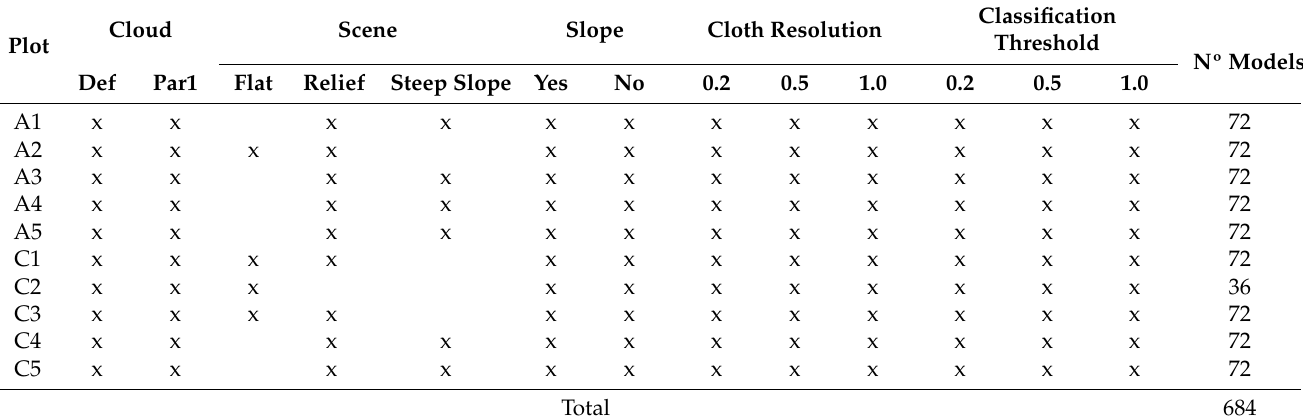
Figure 3. Workflow point-cloud processing. Numbers in parentheses indicate the number of levels for each parameter. Numbers inside brackets indicate the number of outputs for every step. Table 2. Point-cloud classification parameters for canopy-height-model